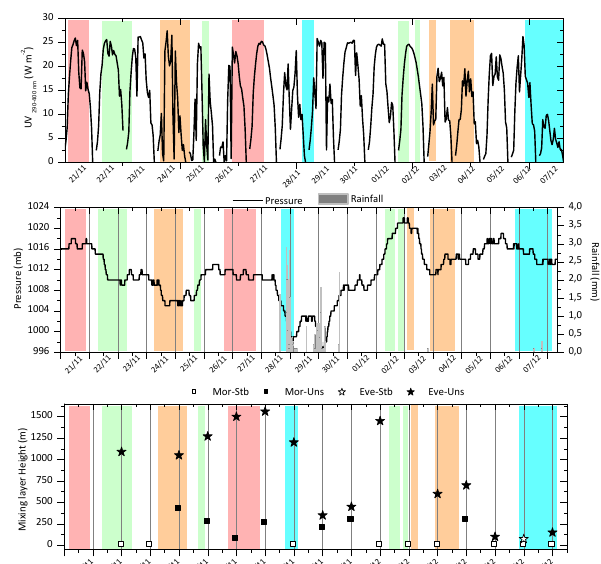
Fig. 4b. Temporal evolution of ultraviolet radiation, pressure and rainfall using 10min averages and mixing layer height obtained from soundings (Mor-Stb: morning sounding with stable condi- tions, Mor-Uns: morning sounding with unstable conditions, Eve- Stb: evening sounding with stable conditions and Eve-Uns: evening sounding with unstable conditions) during the whole DOMINO campaign. Periods classified into distinct sectors of air mass origin are marked by shaded areas as in Fig.